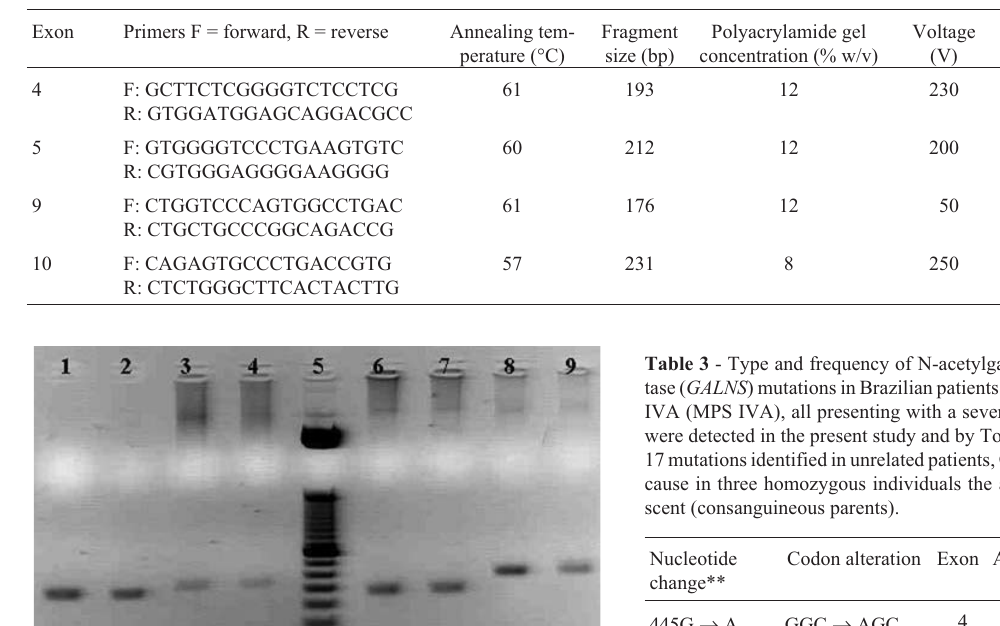
Table 2 - Polymerase chain reaction (PCR) and single-strand conformation polymorphism (SSCP) analysis conditions.